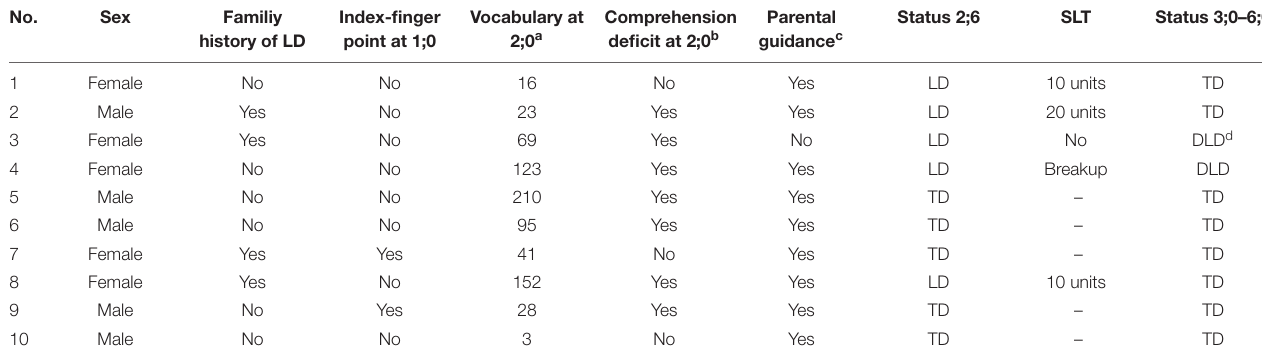
TABLE 4 | Development of 10 children with LD at 2;0.